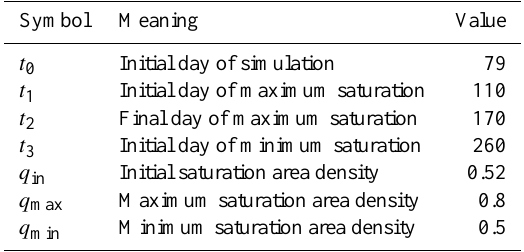
Table 2. Parameter values for Eq. (7). We infer the values from the dynamics of the grid cells belonging to the saturated surface class as in Fig. 2. Days are computed according to the Julian